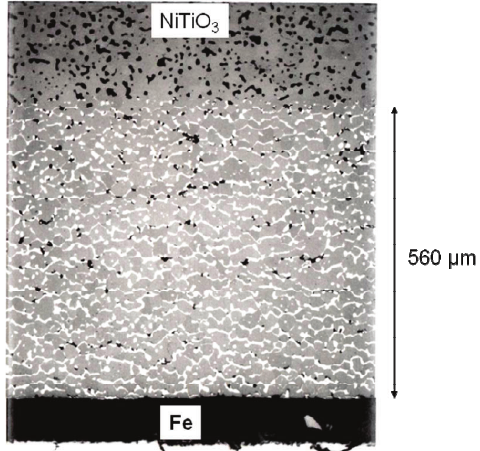
Figure 1. Cross-section through the reaction-diffusion cou- ple Fe-NiTiO 3 along the diffusion direction showing the formation of metal-ceramic composite through the dis- placement reaction, Fe C NiTiO 3 D “Ni” C “FeTiO 3 ”, at 1273 K after 129.6 ks. Bright phase is (Ni-Fe) alloy; grey phase is oxide solid solution with ilmenite structure; dark areas in NiTiO 3 and product layer are